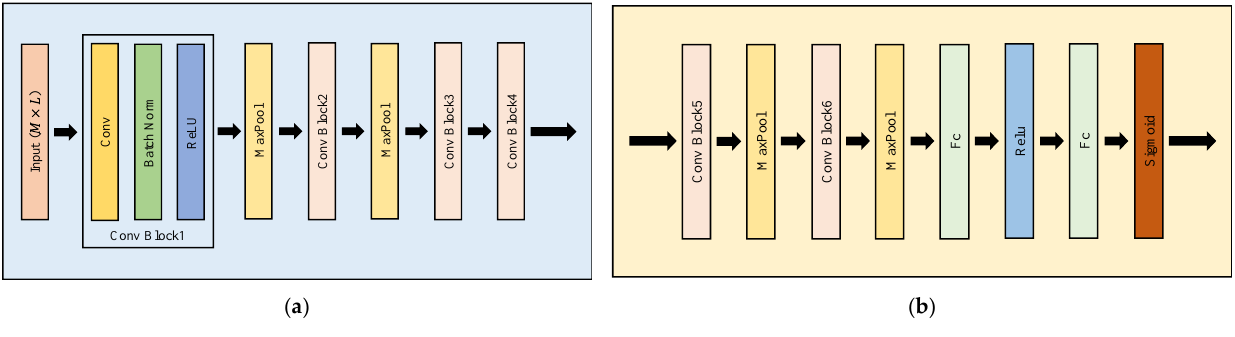
Figure 4. Network structure of MHFNet. ( a ) Network structure of the feature extraction model; ( b ) network structure of the fusion module.